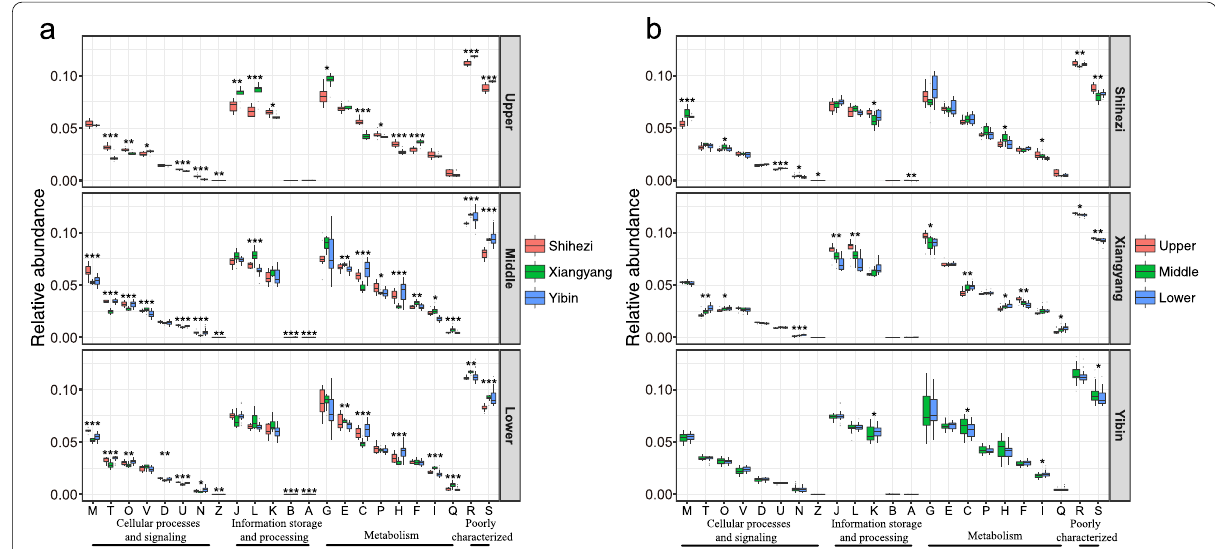
Fig. 5 Effect of depth ( a ) and distillery ( b ) on COG function of bacterial communities. The alphabetic codes represent COG functional categories, as follows: A RNA processing and modification; B chromatin structure and dynamics; C energy production and conversion; D cell cycle control, cell division, and chromosome partitioning; E amino acid transport and metabolism; F nucleotide transport and metabolism; G carbohydrate transport and metabolism; H coenzyme transport and metabolism; I lipid transport and metabolism; J translation, and ribosomal structure and biogenesis; K transcription; L replication, recombination, and repair; M cell wall/membrane/envelope biogenesis; N cell motility; O posttranslational modification, protein turnover, and chaperones; P inorganic ion transport and metabolism; Q secondary metabolitesmetabolite biosynthesis, transport, and catabolism; R general function prediction only; S function unknown; T signal transduction mechanisms; U intracellular trafficking, secretion, and vesicular transport; V defense mechanisms; W extracellular structures; Y nuclear structure; Z cytoskeleton. Significant differences are illustrated with *** P < 0.001, **0.001 P < 0.01, and *0.01 P < ≤ ≤